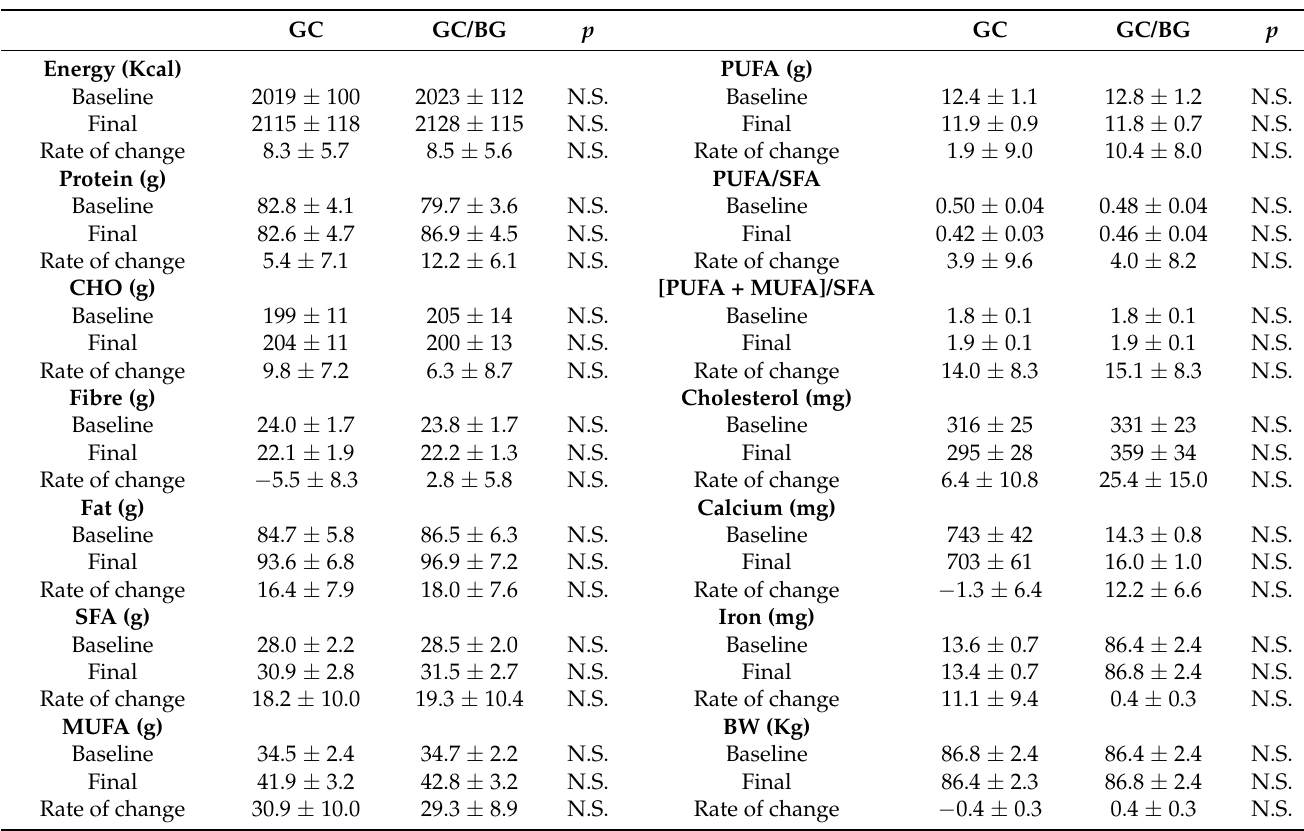
Table 2. Energy, macronutrient, and micronutrient intakes recorded in 72-h reports filled in by volunteers before each study visit, and body weight